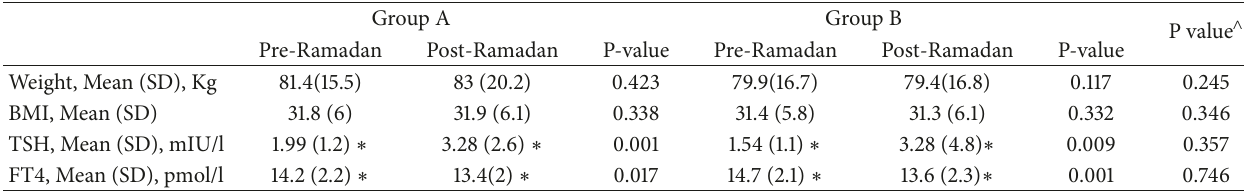
Table 2: Changes in clinical data between Group A and Group